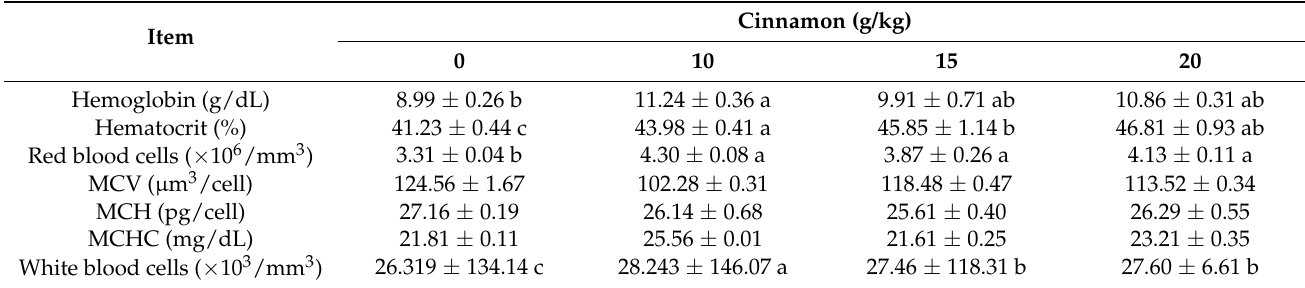
Table 4. Hematological indices of European sea bass fed dietary cinnamon.